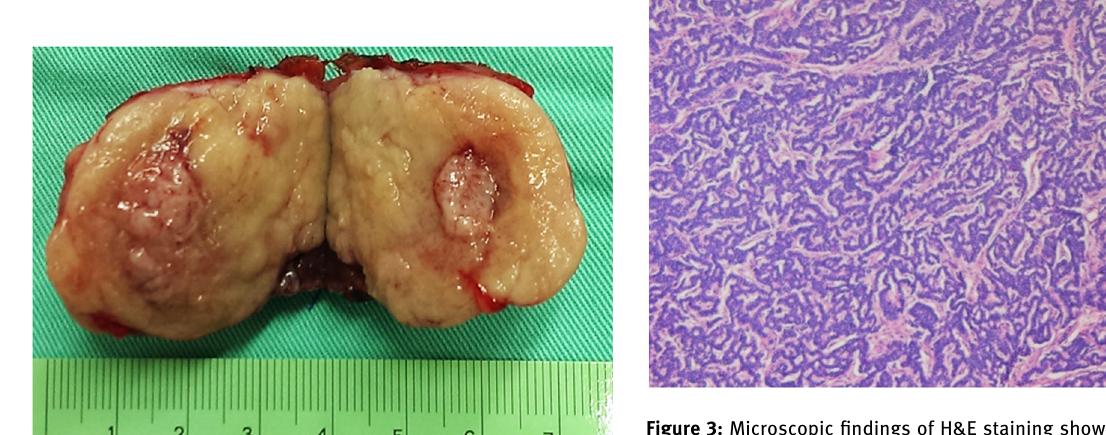
Figure 3: Microscopic fi ndings of H&E staining showed that the tumor grew in a gyriform pattern with hyperchromatic nuclei. NET, neuroendocrine